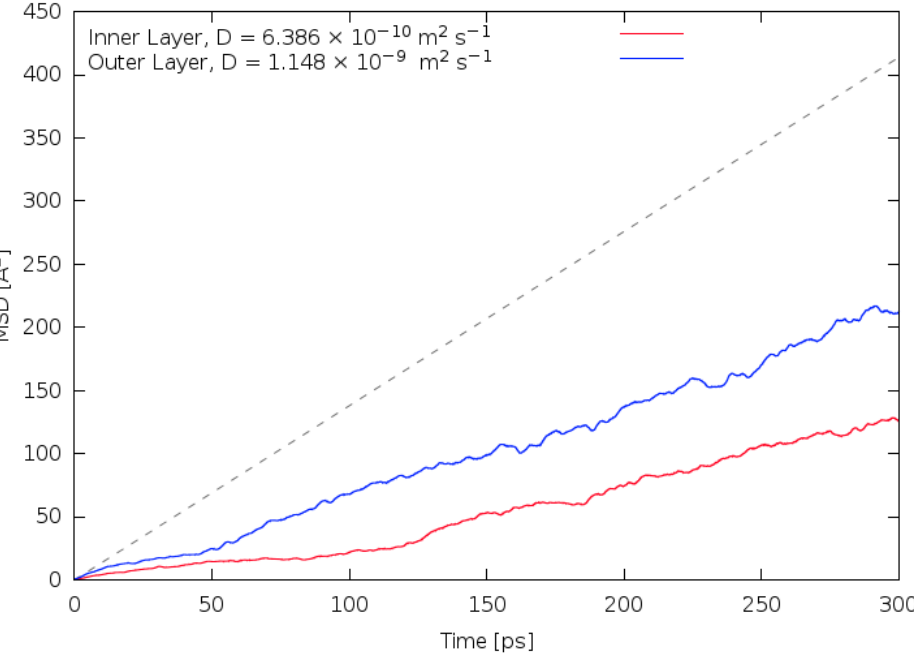
Figure 5. Mean square displacement (MSD) of water molecules in different layers at the water ‐ TiO 2 anatase (110) interface for 300 ps sub ‐ intervals. The self ‐ diffusivity experimental value of 2.3 × 10 − 9 m 2 s − 1 for bulk ‐ water—represented by the grey dotted line—is shown as reference.